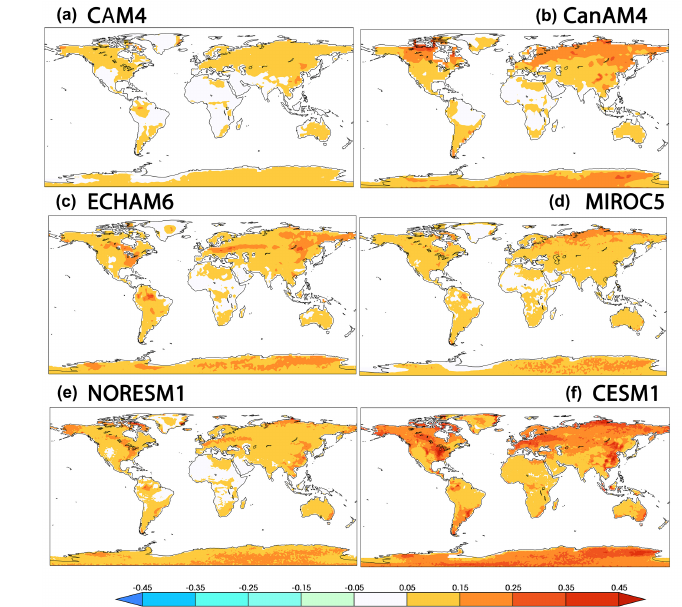
Figure A3. Standard error estimates of 20-year return values of TX3x ( ◦ C) in the 1.5 or 2.0 ◦ C HAPPI simulations. (a) CAM4. (b) CanAM4. (c) ECHAM6. (d) MIROC5. (e) NorESM1. (f)